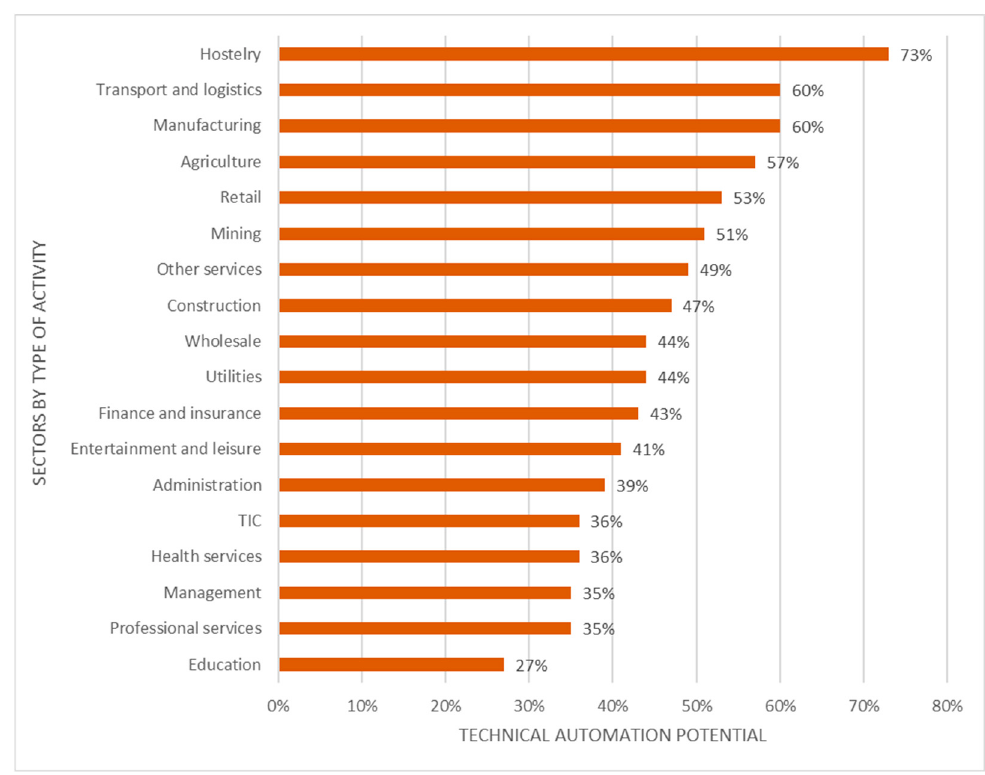
Figure 7. Technical automation potential by type of activity (2017) [57].